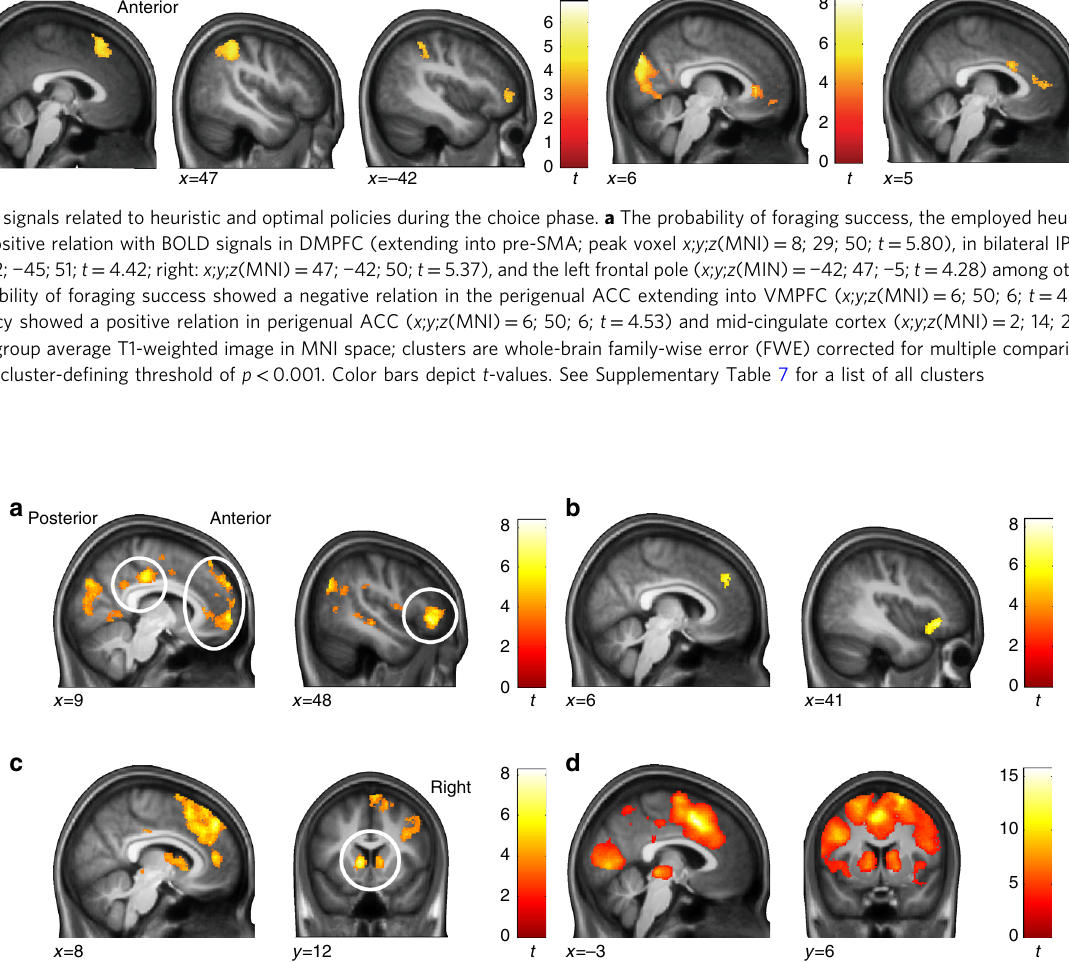
Lower choice uncertainty of the optimal policy scaled with activity in DMPFC, extending into ACC ( x ; y ; z (MNI) = 6; 42; 38; t = 4.81), and in the IFG ( x ; y ; z (MNI) = 48; 26; − 9; t = 5.88; Fig. 7b;